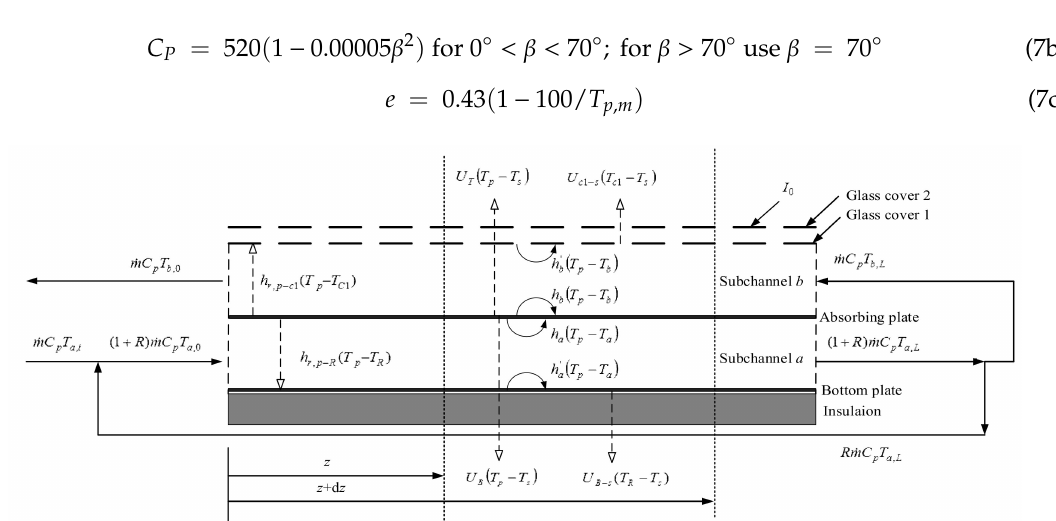
Figure 2. Schematic diagram of the heat flow in a double-pass W-ribs solar air